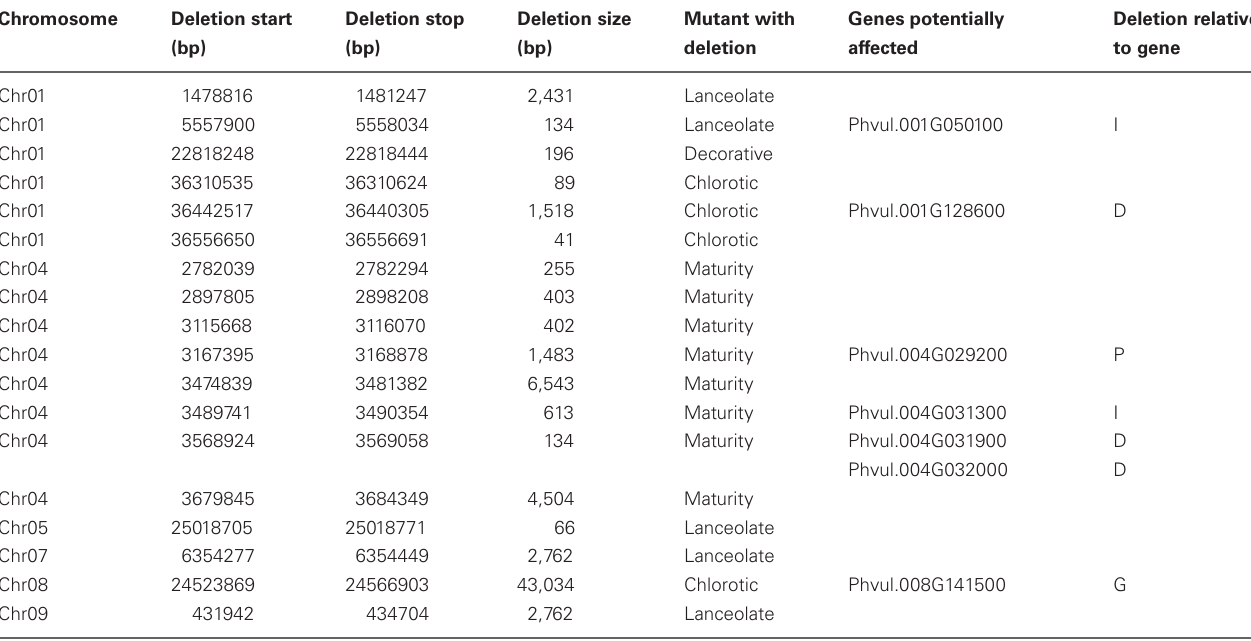
Table 3 | Putative fast neutron induced genomic deletions.